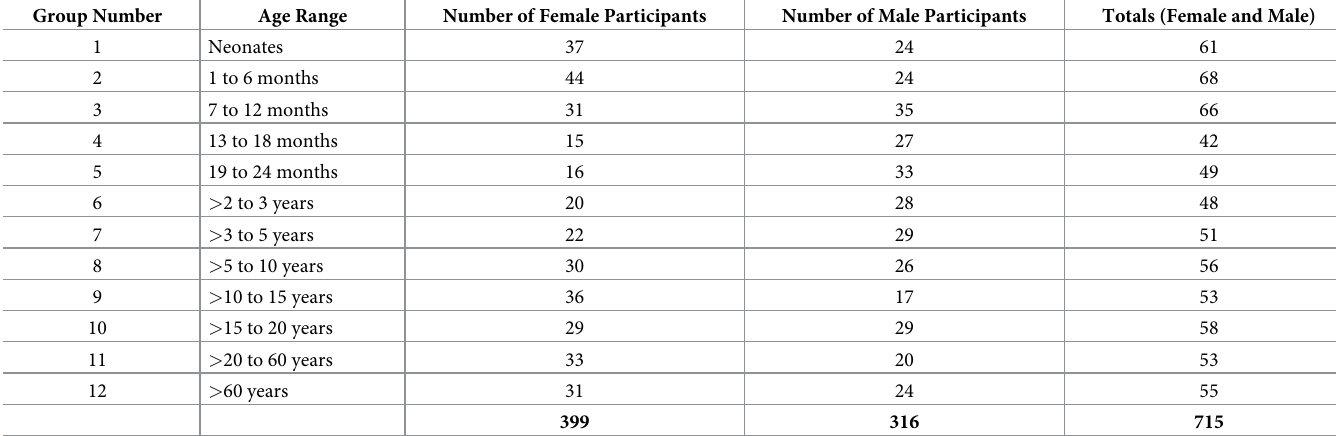
Table 1. Age distribution of HIV-negative study participants according to gender.